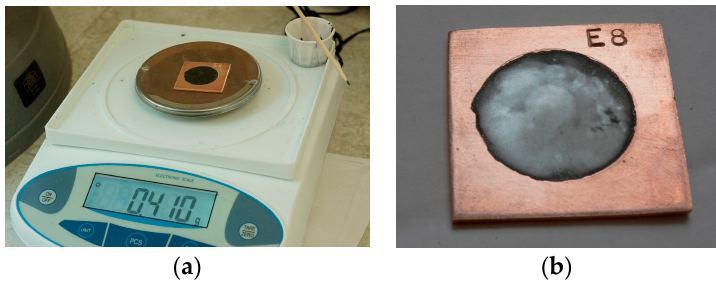
Figure 2. Samples after bonding. Figure 3 . Samples after bonding. Figure 3 . Samples after bonding.